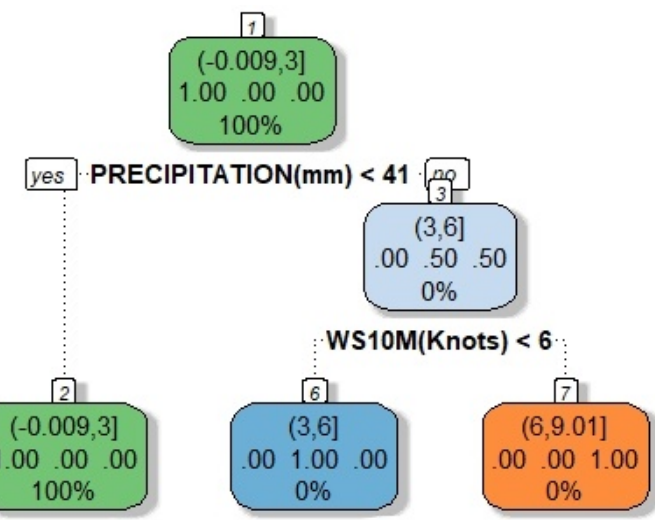
Figure 7. Decision tree predicting the ranges of delays within a single day.